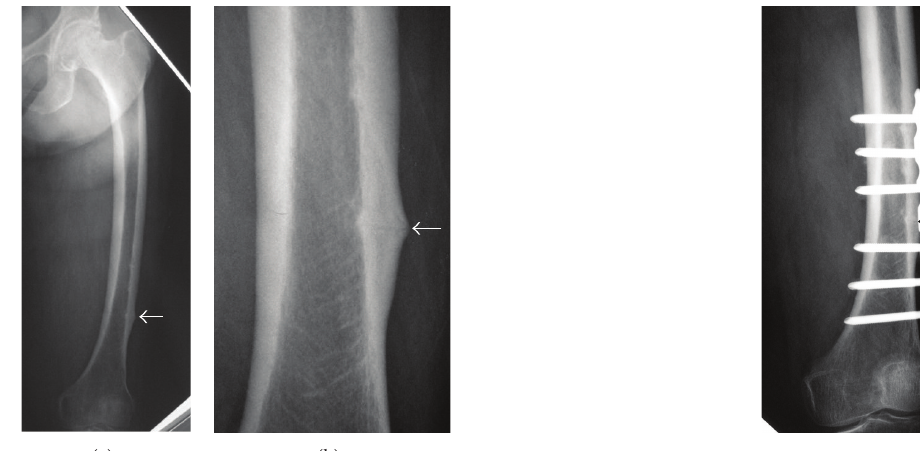
Figure 2: Anteroposterior radiograph of the left femur treated sur- gically using a locking plate. Black arrow shows original horizontal